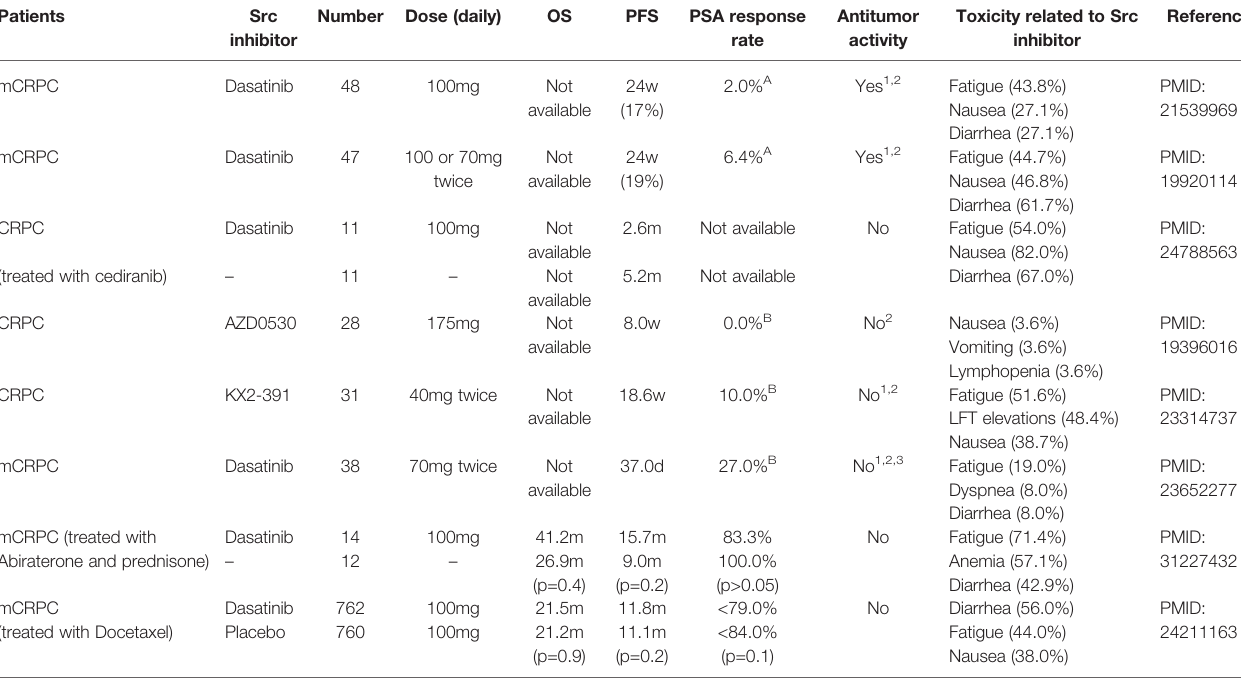
TABLE 1 | Findings for clinical trials using Src inhibitor. Patients Src Number Dose inhibitor